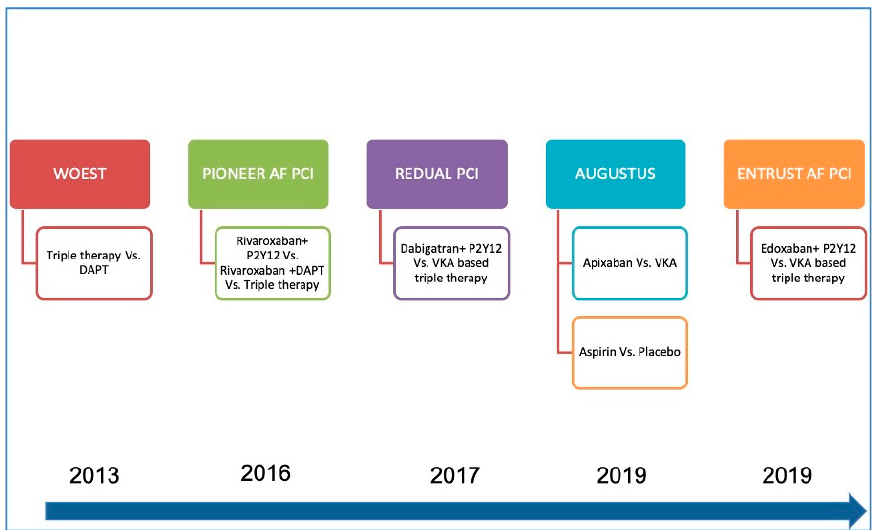
Figure 2. Timeline of pivotal trials comparing conventional triple therapy with dual therapy (either VKA or NOAC based). In the PIONEER AF PCI study, two doses of rivaroxaban were tried—2.5 mg and 5 mg. Similarly, in REDUAL PCI, both 110 mg and 150 mg doses were studied. AUGUSTUS PCI was a 2 × 2 factorial evaluating apixaban versus warfarin and aspirin versus no aspirin. (DAPT—dual antiplatelet therapy; P2Y12—clopidogrel; VKA—vitamin K